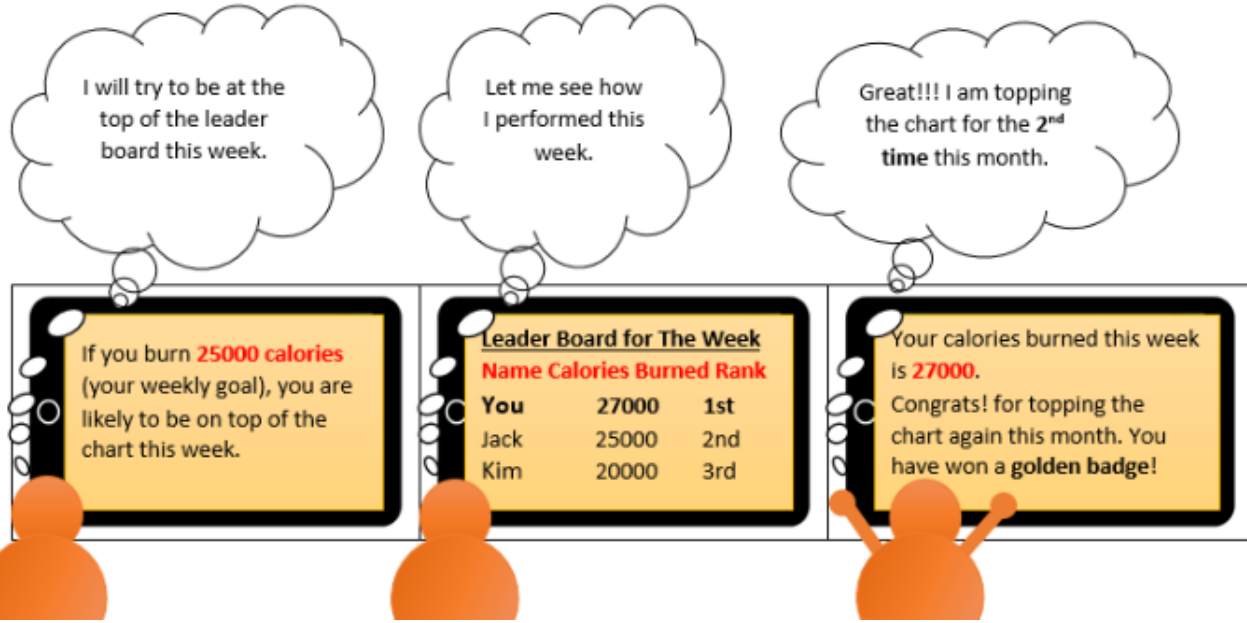
Figure A4. Low-fidelity storyboard illustrating the Competition feature of the fitness app [30].